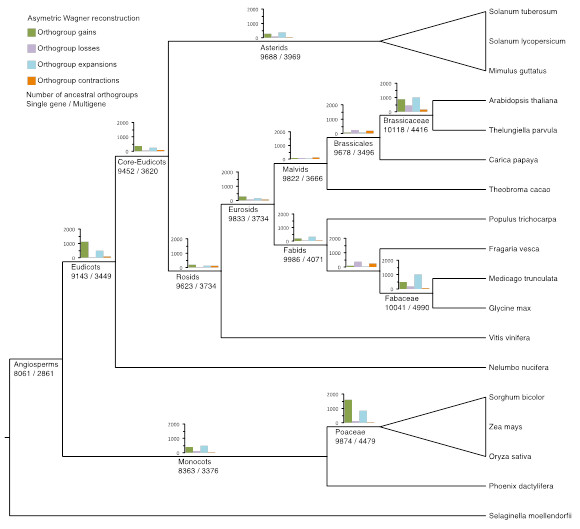
Orthogroup dynamics in lotus and other angiosperm genomes. Ancestral gene content and gene family (orthogroup) dynamics in lotus and other eudicot and monocot genomes identify expansion of the number of gene families and gene content associated with the ancestral eudicot.